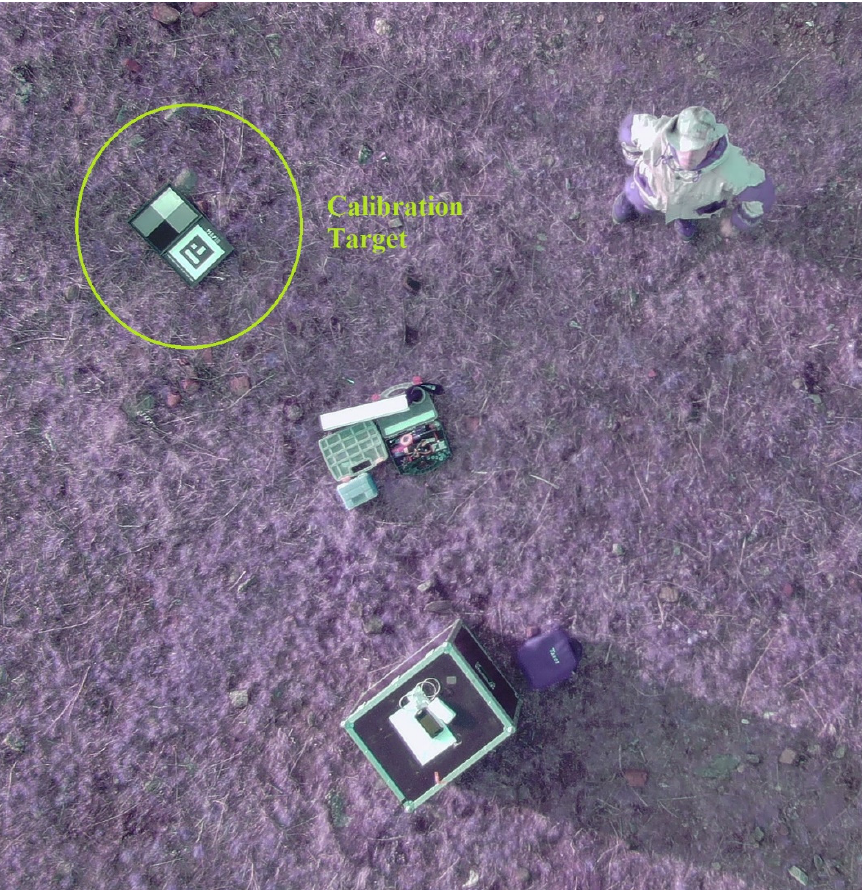
Figure 5. MAPIR calibration target.